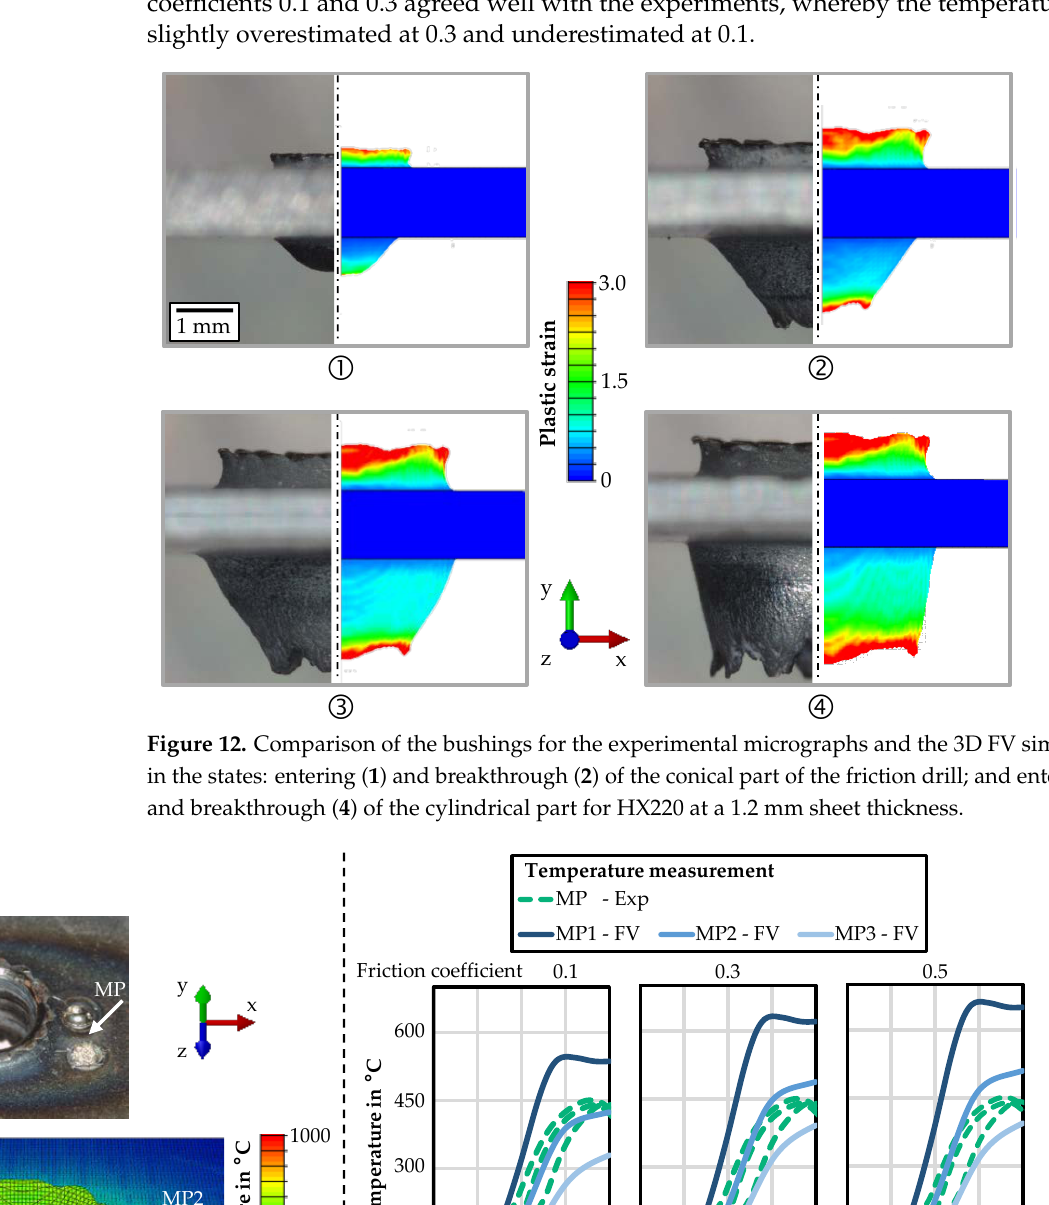
Figure 11. Geometry shapes of the resulting bushing for HX220 at a 1.2 mm sheet thickness: experiment ( a ); 3D FE ( b ); 2D FE ( c ); 3D FV ( d ); and 3D FV without rotation ( e ).